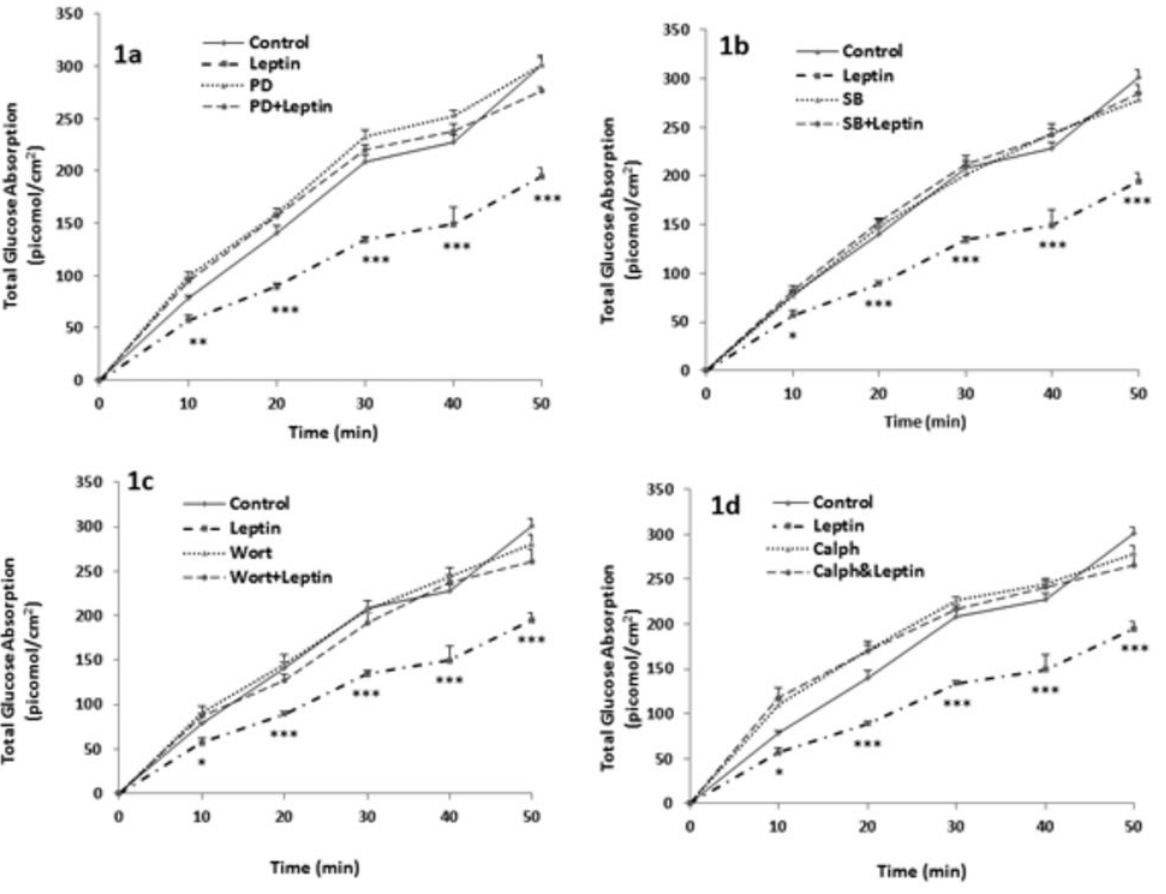
Figure 1. Involvement of MEK/ERK, p38MAPK, PI3K, and PKC in leptin’s action. Effect of leptin (10 nM) on glucose absorption by Caco-2 cells in presence and absence of (a) PD98059, inhibitor of MEK/ERK, (b) SB202190, an inhibitor of p38MAPK, (c) Wortmannin, an inhibitor of PI3K, (d) Calphostin C, an inhibitor of PKC. Absorption of glucose was measured at 10- min intervals over a period of 50 min. Values are means ± SEM of 5 observations. * P<0.05, **P<0.01, ***P<0.001: significantly different from all other